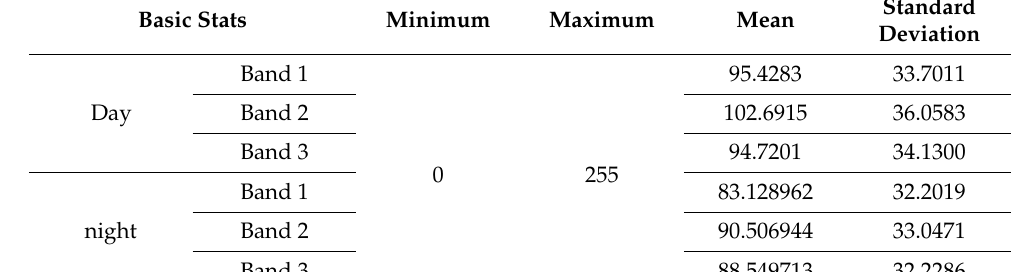
Table 3. The statistics of digital numbers in the TISD’s images.